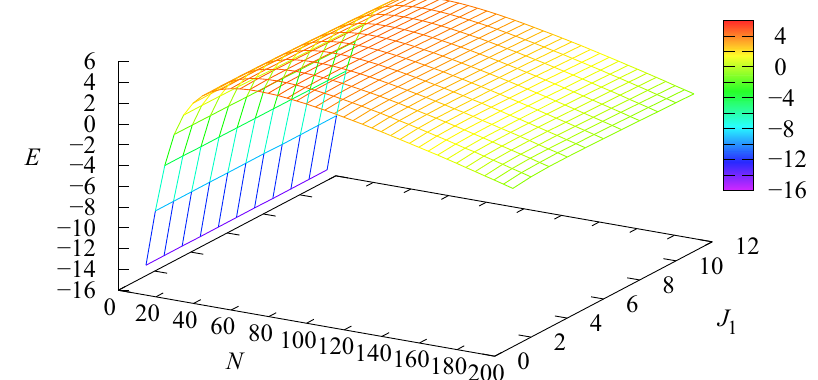
Figure 7. Dependence of the probability P enough - servers on N and J 1